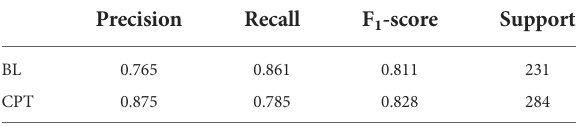
TABLE 2 Sklearn classi fi cation report for laboratory grade pain classi fi er with all features.